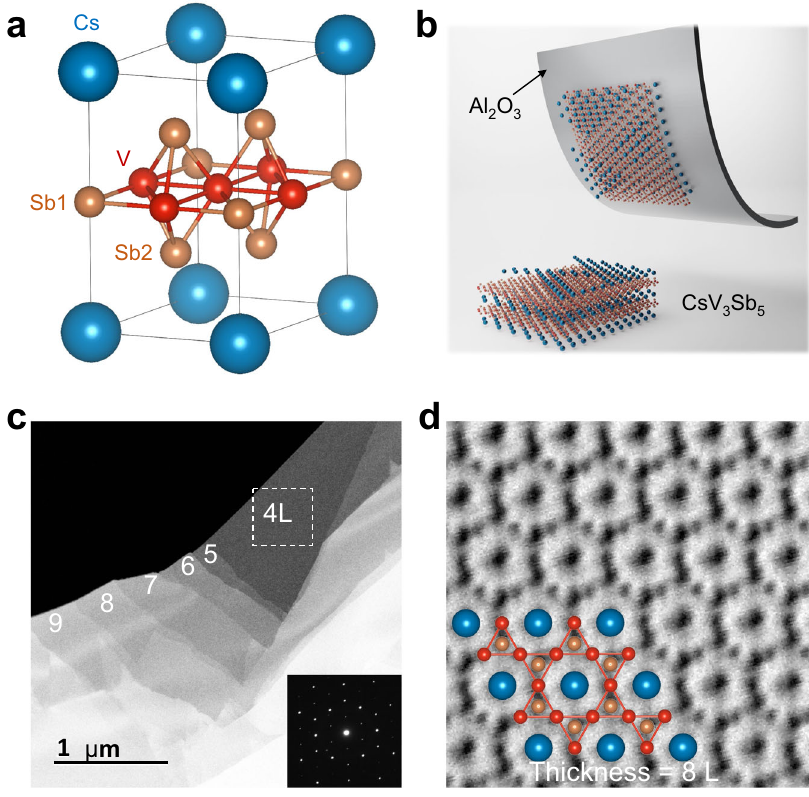
Fig. 1 | Structure and exfoliation of CsV 3 Sb 5 thin fl akes. a Crystal structure of CsV 3 Sb 5 . b Illustrationoftheexfoliationofthin fl akesandthelossofsurfaceCs.The schematic structure of an eight-layer thin fl ake without surface Cs can be found in Supplementary Fig. 3b. c Low-magni fi cation STEM image of the exfoliated fl akes. The determination of the thickness can be found in Supplementary Note 2. The